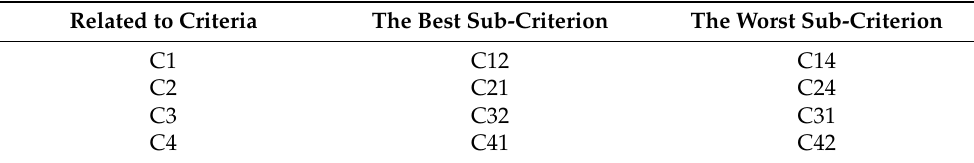
Table 4. The best and worst risk sub-criteria related to each risk criteria. Related to Criteria